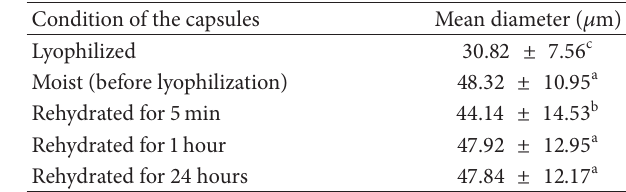
Table 1: Mean diameter and encapsulation efficiency of microcap- sules.